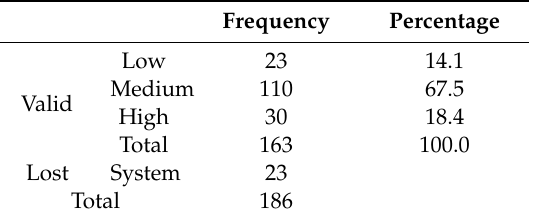
Table 4. Distribution of the sample according to the type of score in SPANE-N.